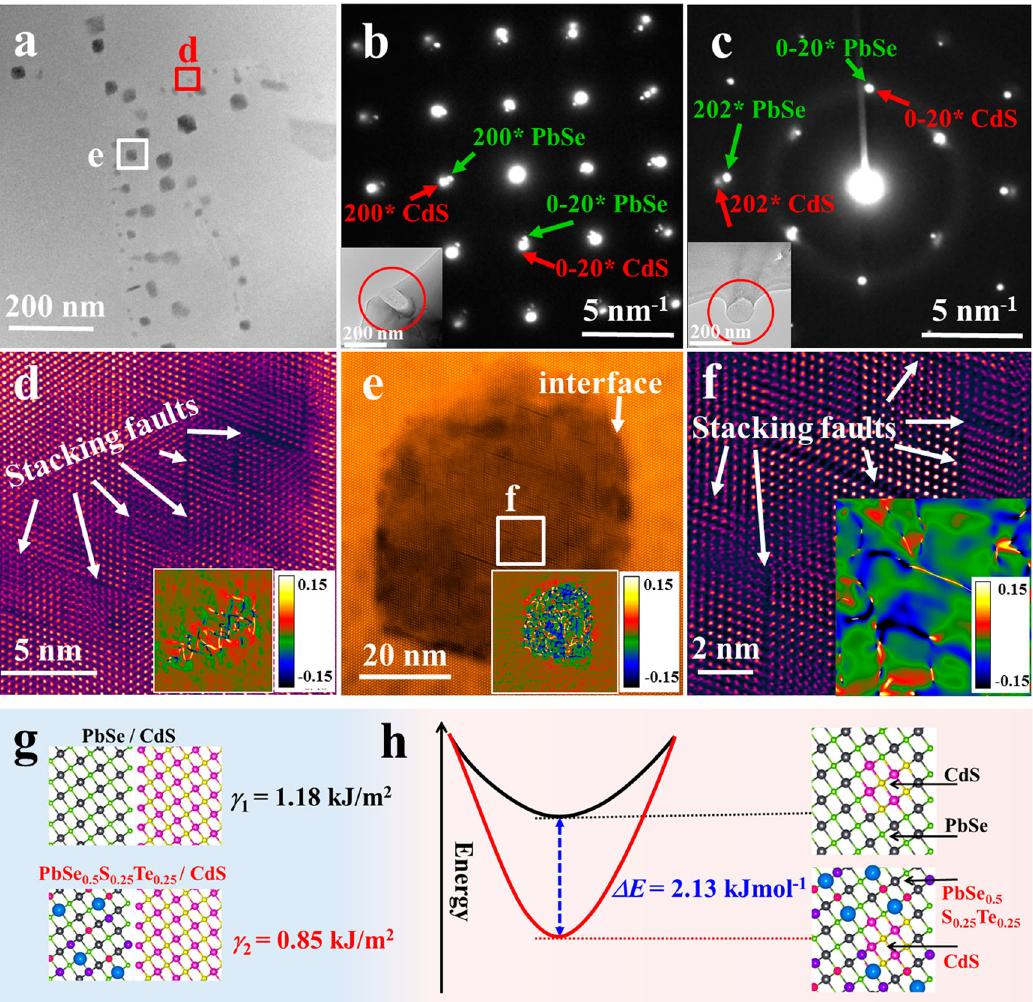
Fig. 4 Microstructure of Pb 0.935 Cd 0.04 Na 0.025 Se 0.5 S 0.25 Te 0.25 sample. a Medium magni fi cation STEM image shows the coexistence of nanoprecipitates and mesoscopic precipitates. Electron diffraction spots along b (001) and c (110) orientations. The green and red arrows represent spots from PbSe and CdS structures, respectively. d , e HAADF images of two typical nanoprecipitates that contain high-density stacking faults. The insets are the GPA results along the xy directions. f The enlarged image of the selected area in e image. The GPA result shows the tense lattice strains around the stacking faults. g Calculated surface energy ( γ ) of PbSe/CdS and PbSe 0.5 S 0.25 Te 0.25 /CdS interfaces. h Calculated deformation energy of rock salt CdS phase in PbSe and PbSe 0.5 S 0.25 Te 0.25 lattice. The crystal structures in g and h represent the calculation